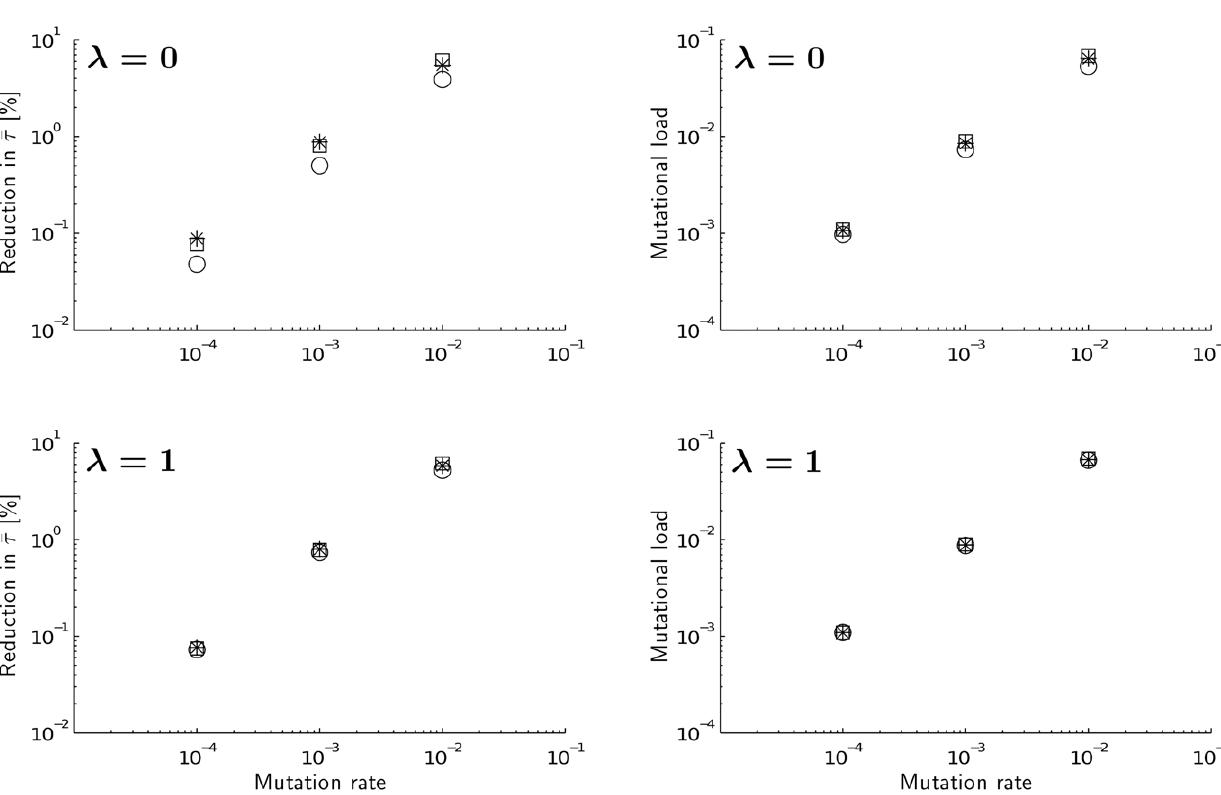
Figure 2. Reduction in mean optimal age at maturity (cid:2) tt due to mutation accumulation (left column) and mutational load (right column) under different levels of the adverse effect of mutations on reproduction l . Background mortality m e =0.01 for all graphs. The different levels of adverse effects of mutations on mortality are captured by circles ( d =0.001), stars ( d =0.01) and squares ( d =0.1).